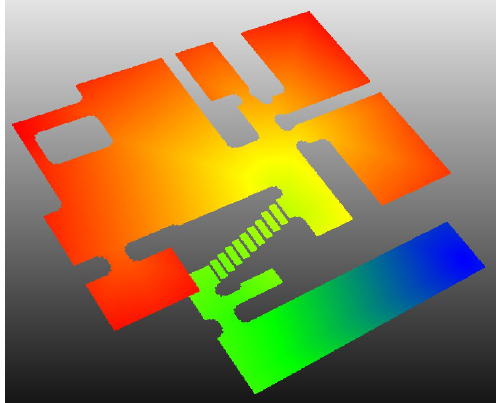
Fig 2. Distance transform of all navigable voxels to an exit voxel at the right side on the ground